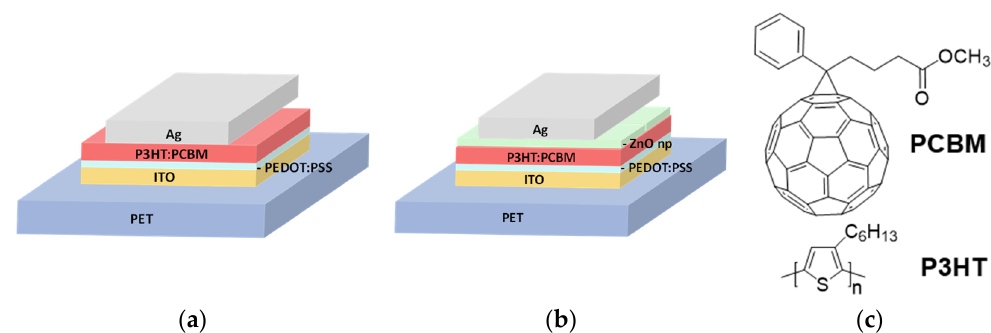
Figure 1. Photovoltaic device architectures: ( a ) without the presence of ETL, ( b ) with the presence of ETL, and ( c ) the chemical structure of active layer ingredients.